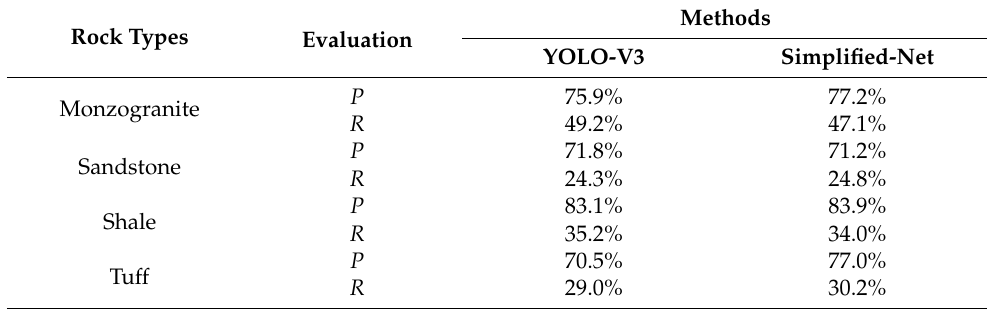
Table 4. The best model performance of YOLO-V3 and Simplified-Net on four types rock lithology.